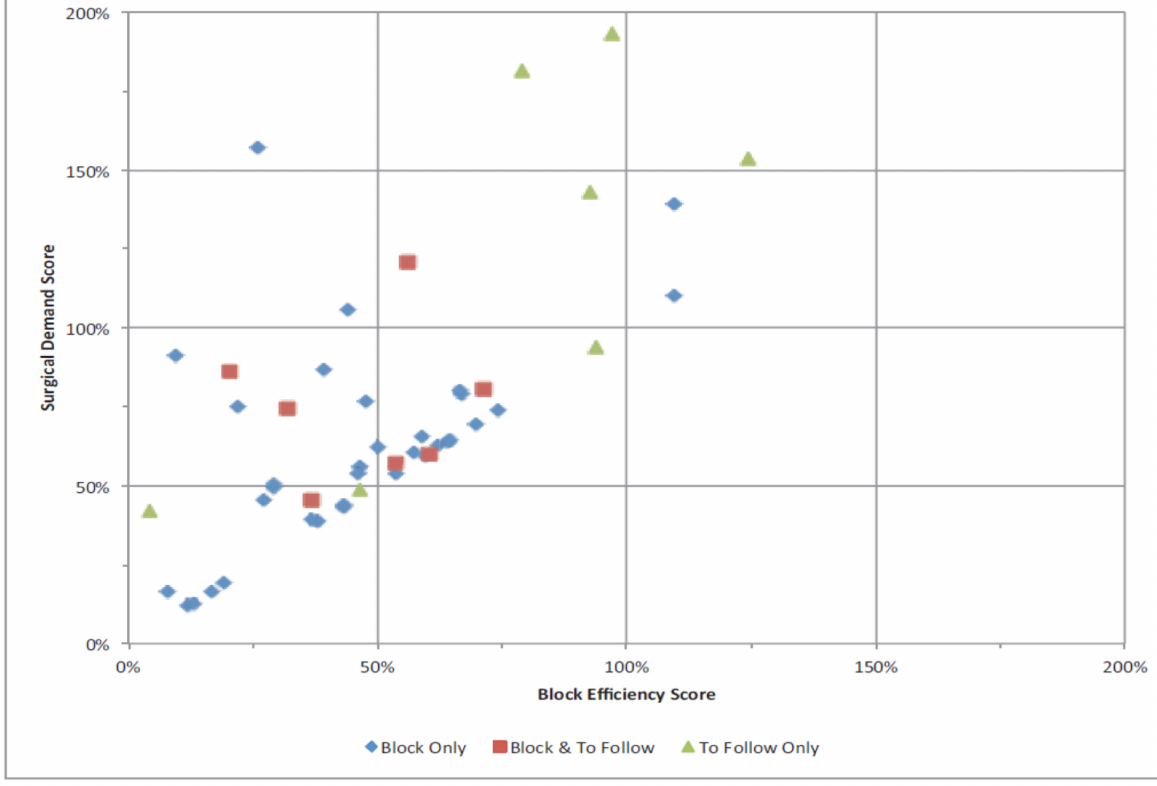
Figure 1. Demand–supply match and block efficiency scores of